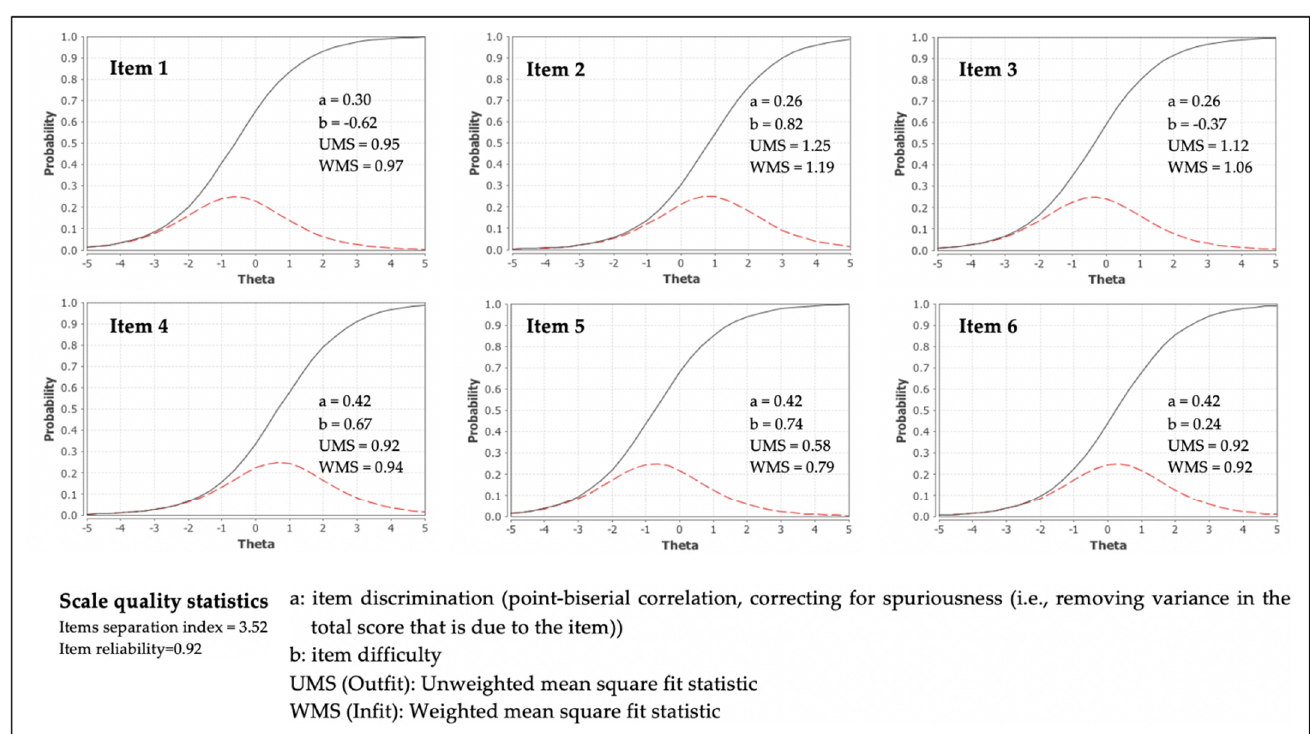
Figure 2. NVS-PTeen items: characteristic and information curves ( N = 386).